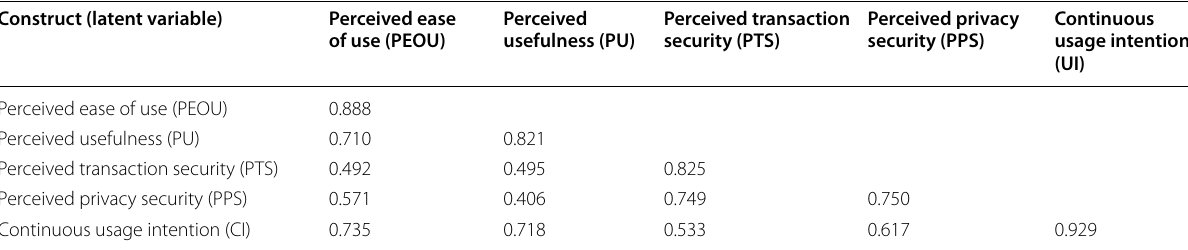
The diagonals show the square roots of the AVEs. Values below diagonals are the inter-construct correlation values